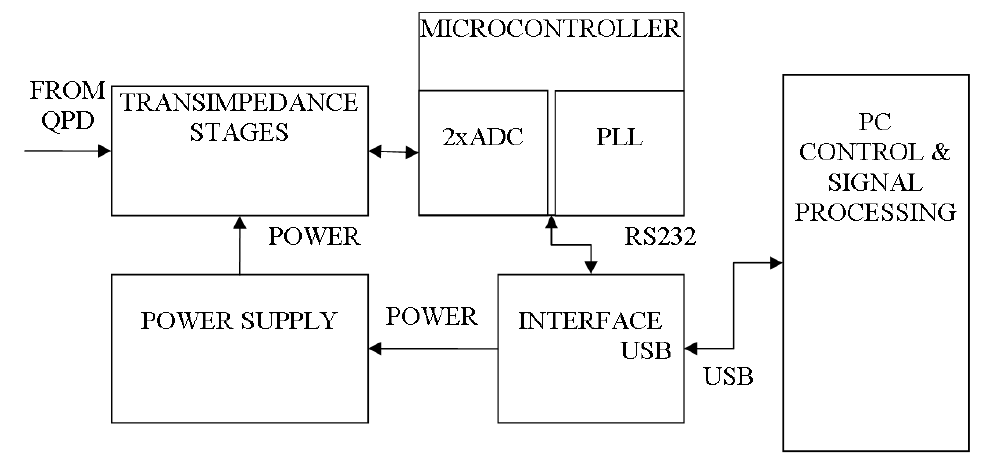
Figure 3. Block diagram of the signal processing